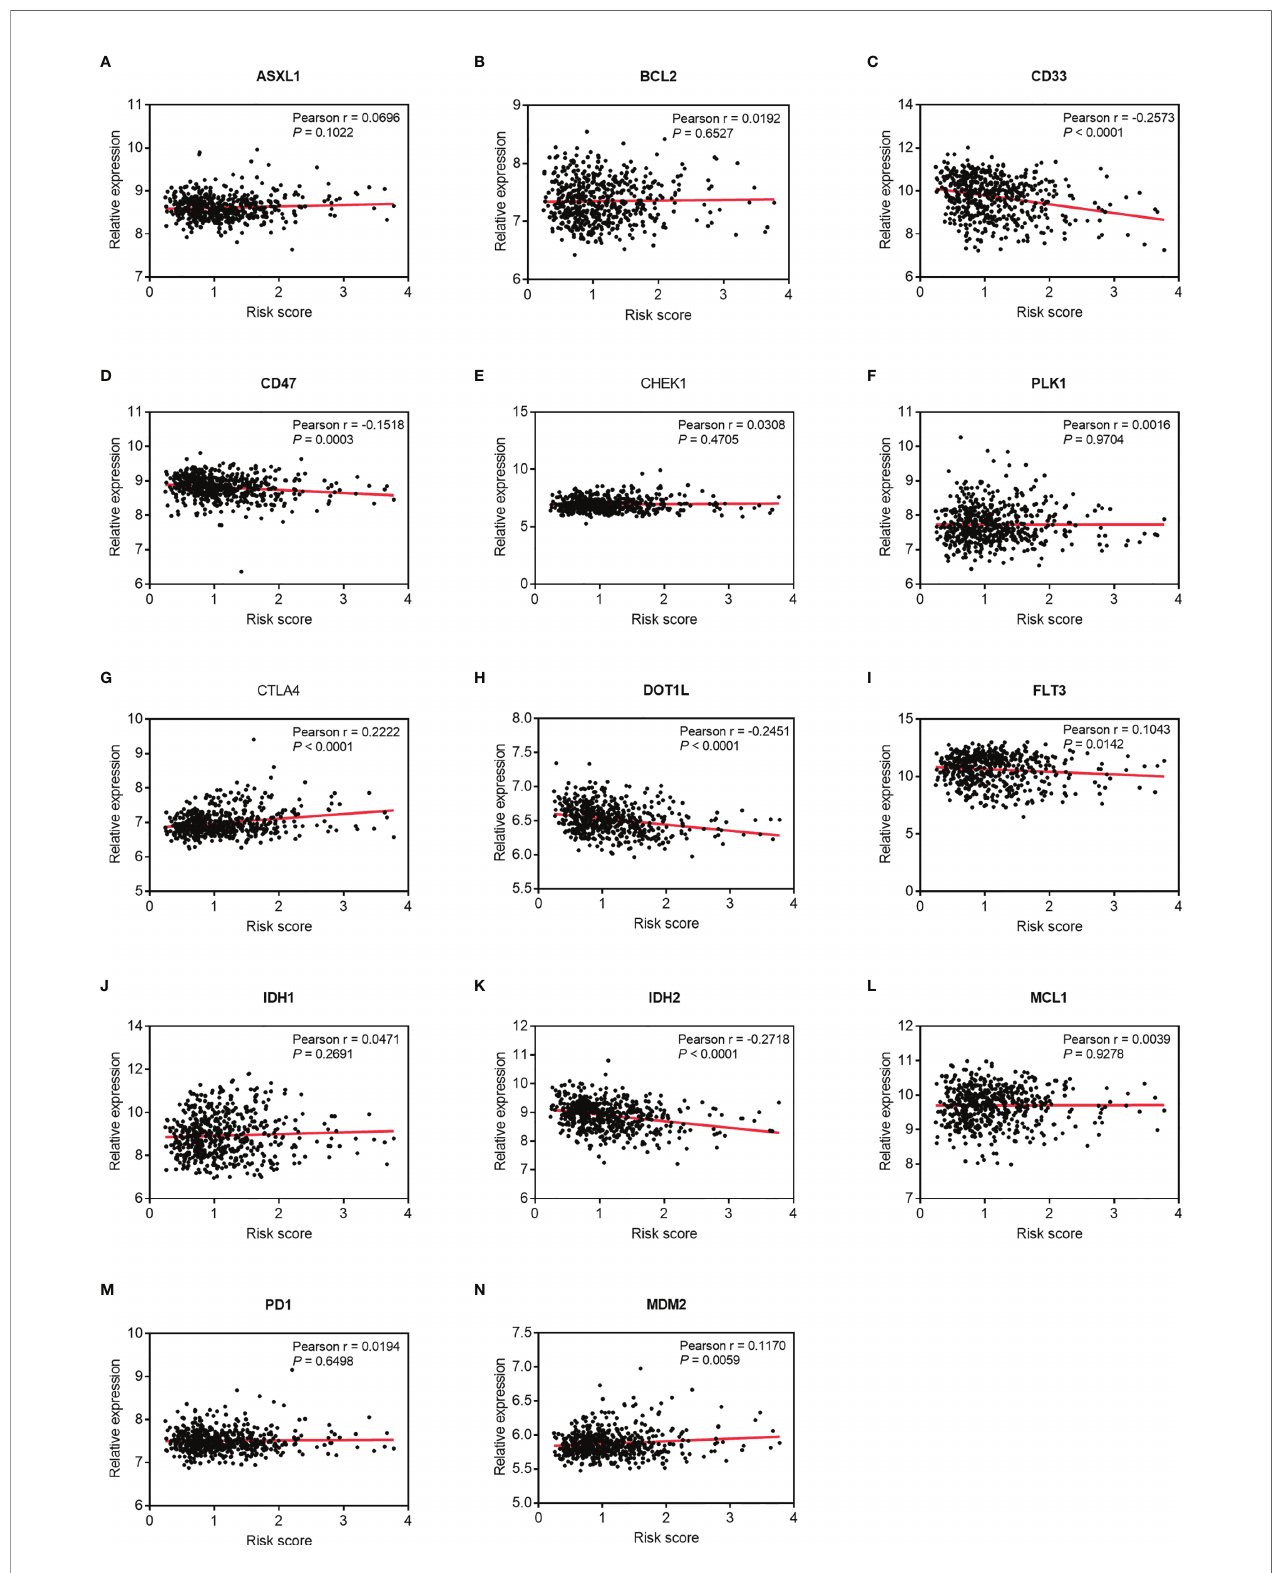
FIGURE 7 | Pearson correlation of the risk scores of the targets of immunotherapy and targeted therapy. (A) ASXL1. (B) BCL2. (C) CD33. (D) CD47. (E) CHEK1. (F) PLK1. (G) CTLA4. (H) DOT1L. (I) FLT3. (J) IDH1. (K) IDH2. (L) MCL1. (M) PD-1. (N)